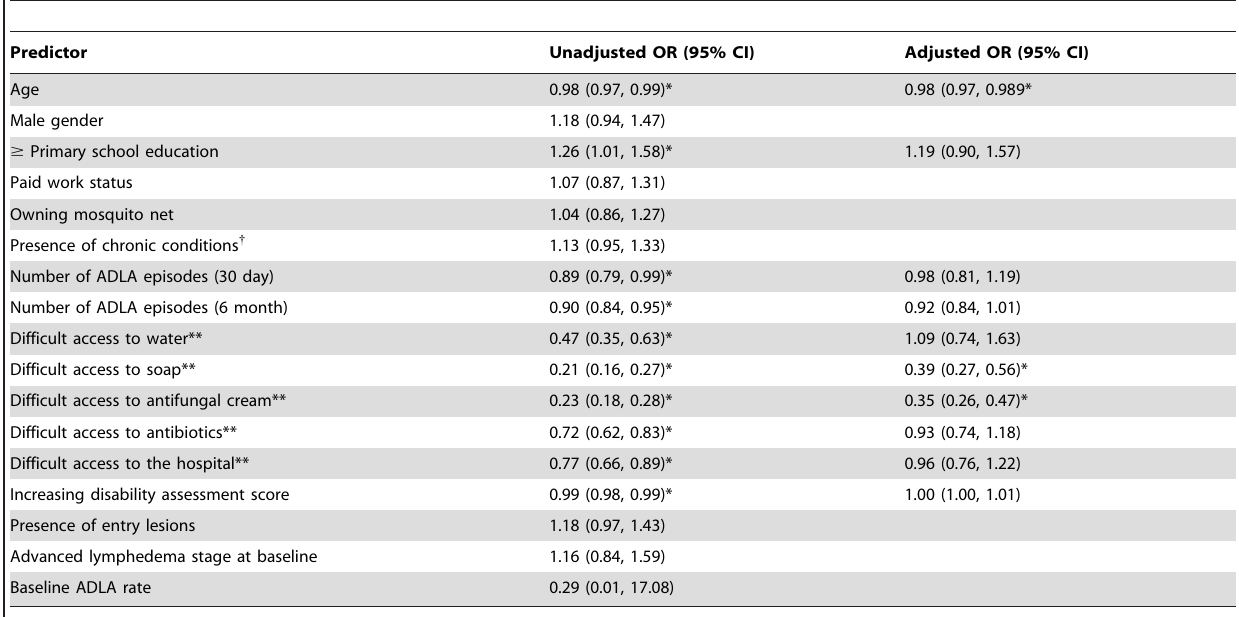
Table 6. Predictors of compliance to lymphedema management techniques among patients enrolled in a lymphedema management program, Khurda District, Odisha State, India, July 2009–July 2011.